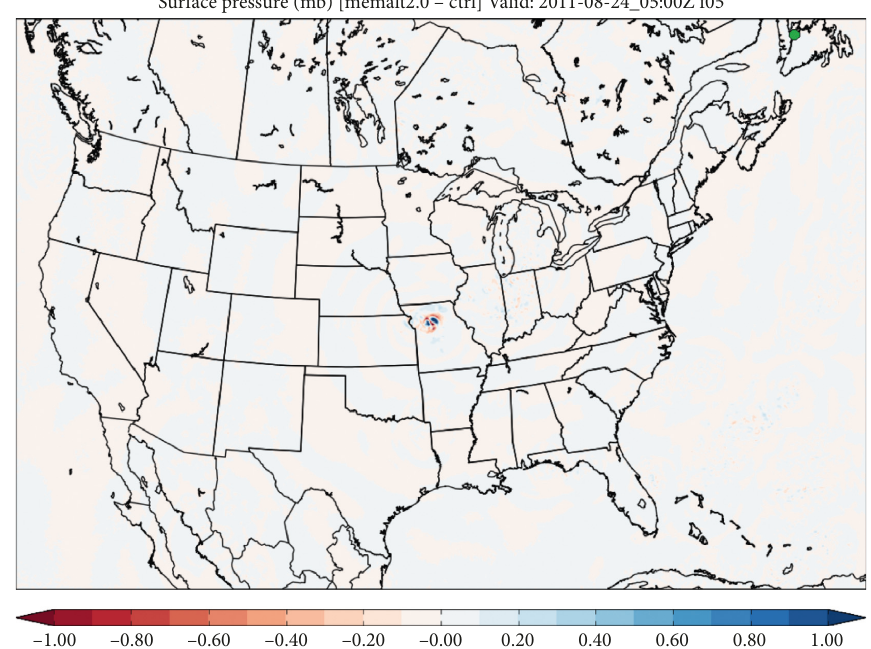
Figure 6: Differences in surface pressure at forecast hour 05 between a run with a 2 ° C stratospheric potential temperature perturbation and a control run. Location of temperature perturbation is shown by a green marker in the upper right part of the